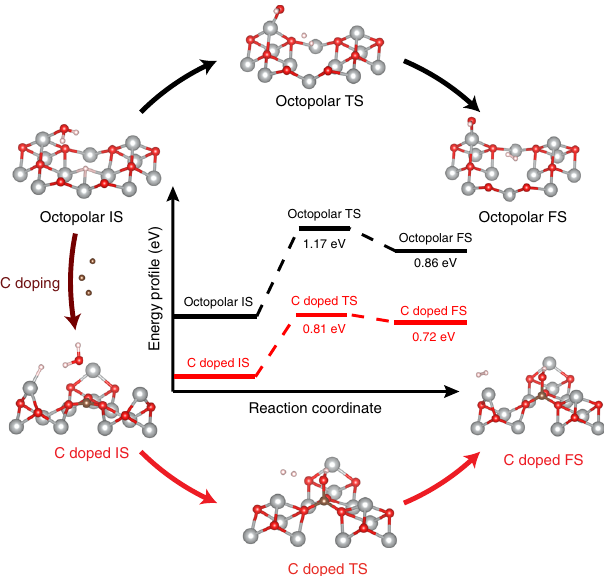
Fig. 7 HER energy pro fi le. The reaction energy pro fi le of the Heyrovsky step for o-surface and C-surface. The corresponding IS, TS, and FS structures for o-surface and C-surface are listed in the surrounding